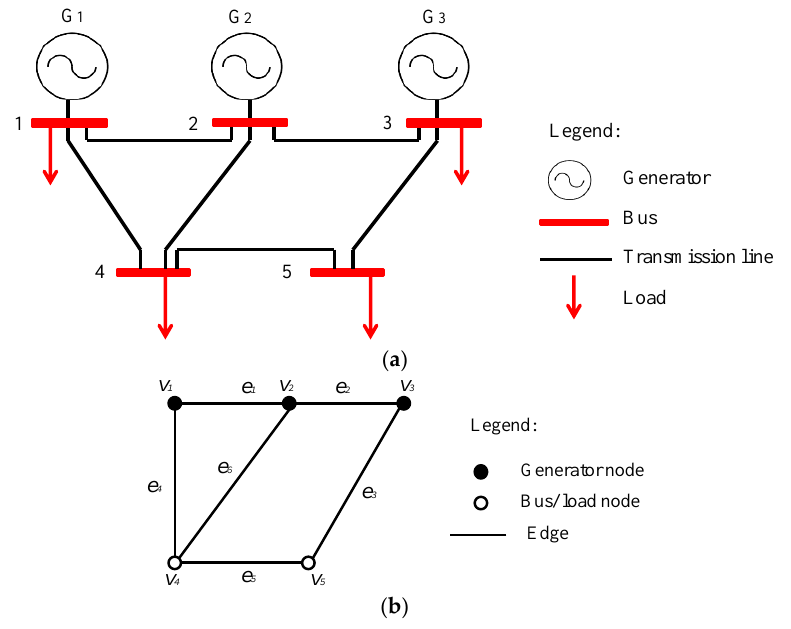
Figure 3. ( a ) IEEE 5-bus system; ( b ) Graph representation of IEEE 5-bus system.